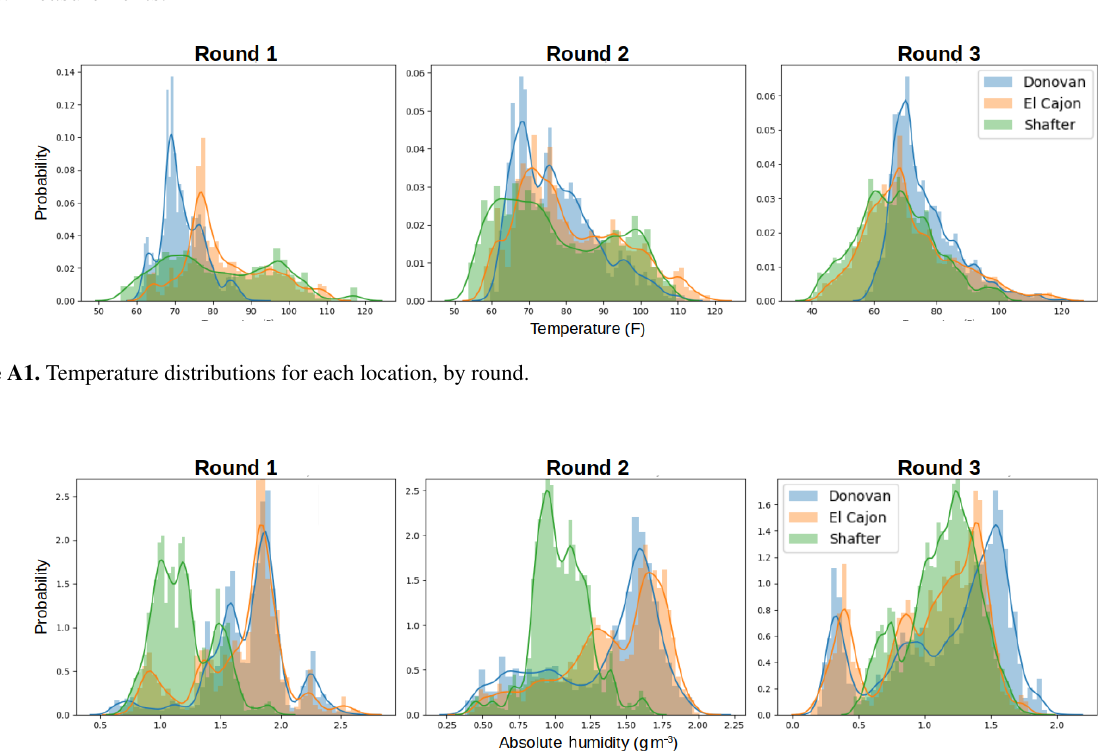
Figure A2. Humidity distributions for each location, by